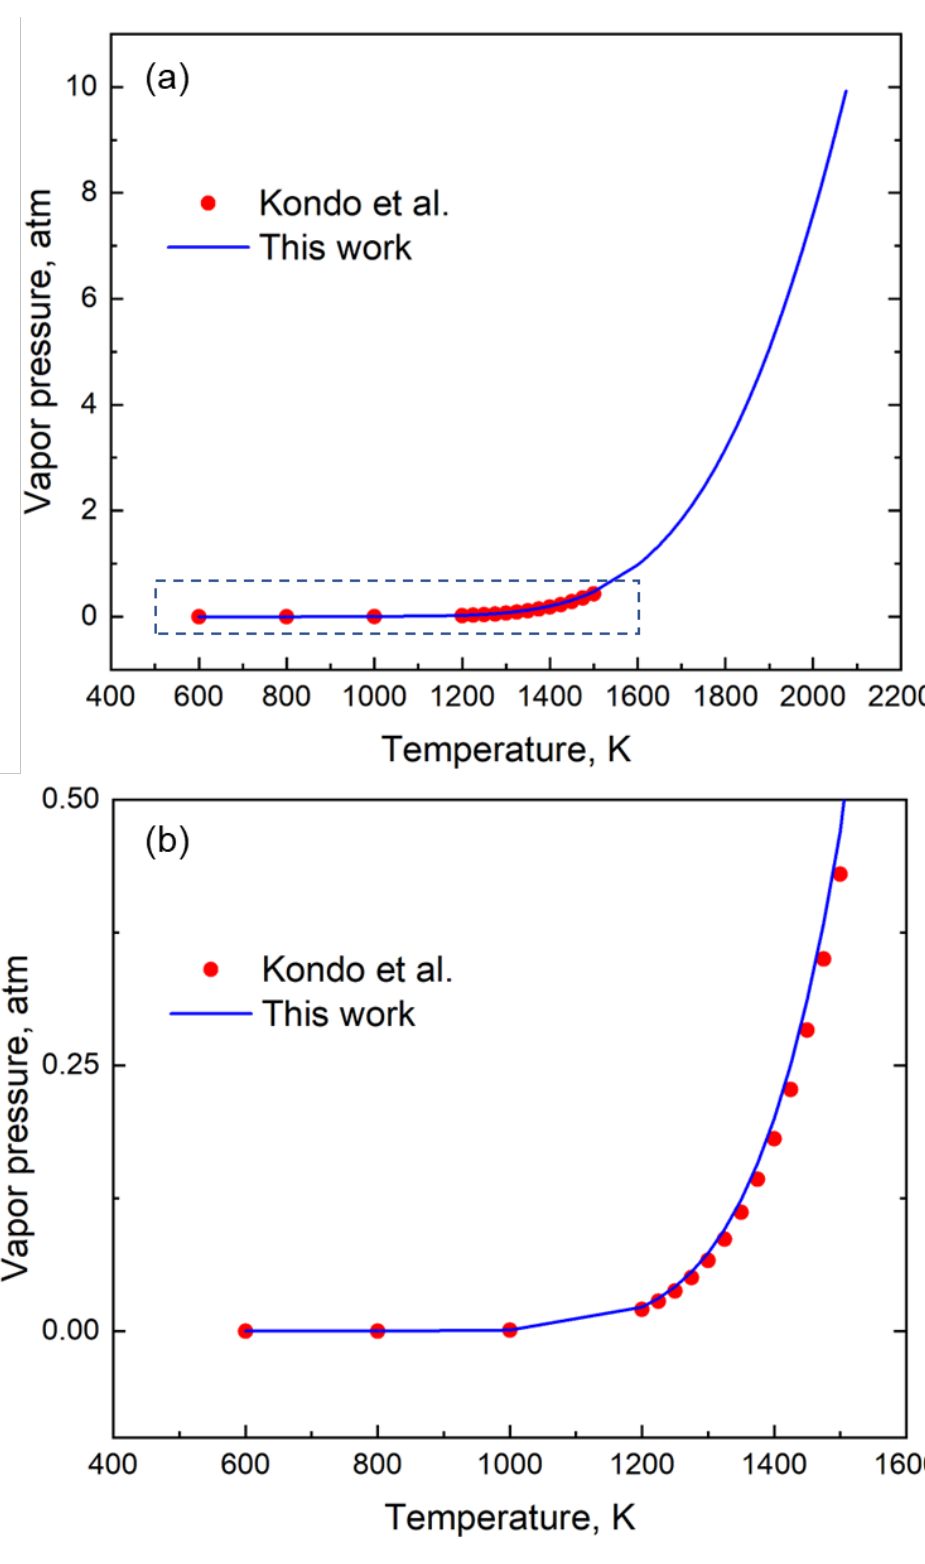
Figure 6. ( a ) A Comparison of the vapor pressure of Li using coefficients generated using our method (GA) and that of Kondo et al. [22]. ( b ) The enlarged section of the vapor pressure data between 400 K and 1600 K shows the good fit with the equation.